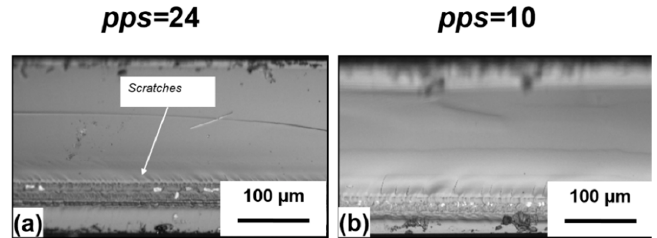
Figure 3. Optical microscope images of the cut edges obtained with pps = 24 and 10, at 50 kHz repetition rate and a pulse energy of 20 μ J. The reduction of the pps from 24 to 10 causes the cut edge not to be perpendicular to the target surface. In ( a ), the image is almost entirely on focus. In ( b ), the part of the cutting edge above the laser damage trace is out of focus, thus indicating a different height with respect to the part below.